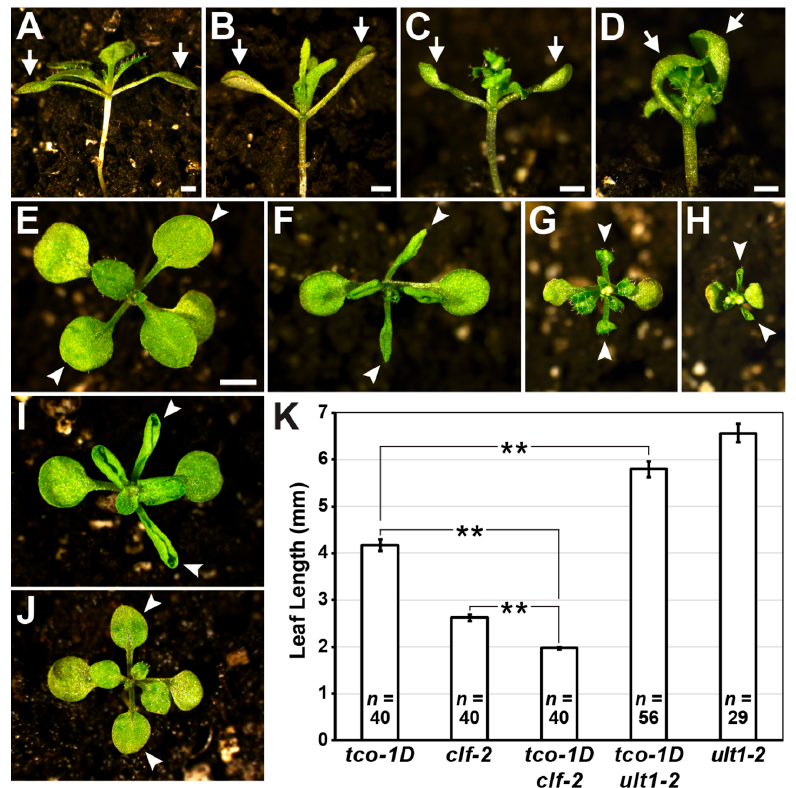
Figure 4. Vegetative defects of tco-1D are enhanced by clf and suppressed by ult1 . ( A – D ) Lateral views of 17 days after germination (DAG) wild type (WT) ( A ), tco-1D ( B ), clf-2 ( C ) and tco-1D clf-2 ( D ) plants, with cotyledons denoted (arrows). ( E – J ) Apical views of 17 DAG WT ( E ), tco-1D ( F ), clf-2 ( G ), tco-1D clf-2 ( H ), tco-1D ult1-2 ( I ) and ult1-2 ( J ) plants, with first vegetative leaves denoted (arrowheads). Bars: ( A – D ) 1 mm; ( E – J ) 2 mm. ( K ) Lengths of first vegetative leaves of tco-1D , clf-2 , tco-1D clf-2 , tco-1D ult1-2 and ult1-2 are shown. Data are represented as mean +/ − SE. Asterisks denote statistically significant differences (** p < 0.001; two-tailed t -test). Sample size ( n ) of each genotype is